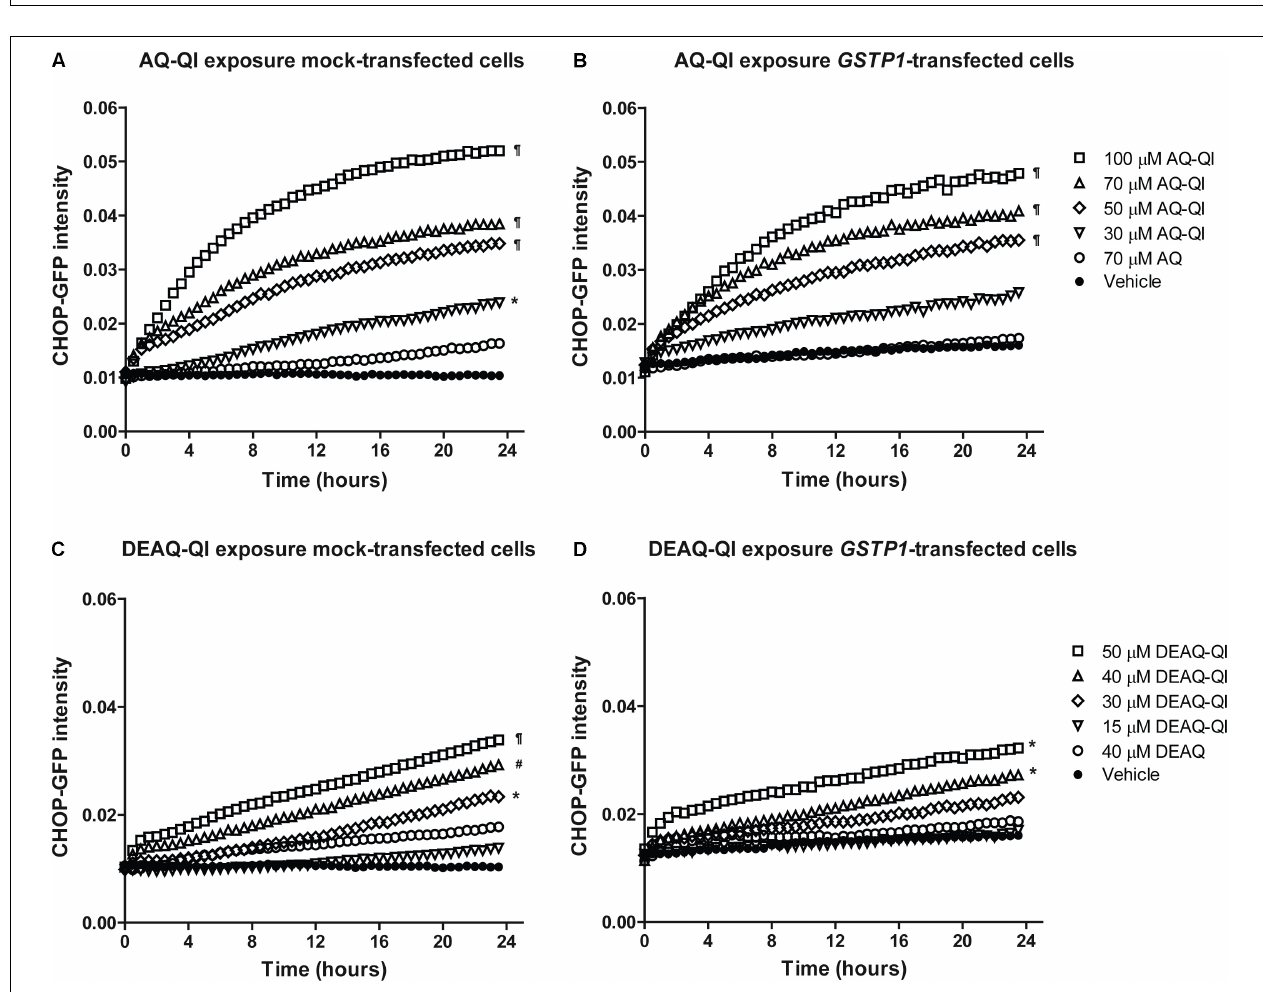
FIGURE 6 | Effects of 50 µ M AQ-QI and 30 µ M DEAQ-QI on intracellular concentrations of reduced GSH (rGSH) (A) , GSSG (B) , and on the ratio of reduced GSH to GSSG (C) in HepG2 cells without BSO pretreatment. Mock- and GSTP1 -transfected cells were treated with 50 µ M AQ-QI or 30 µ M DEAQ-QI for 2.5 h, after which GSH and GSSG levels were quantified as described section “Materials and Methods.” Results are presented as mean ± SD ( n = 3).